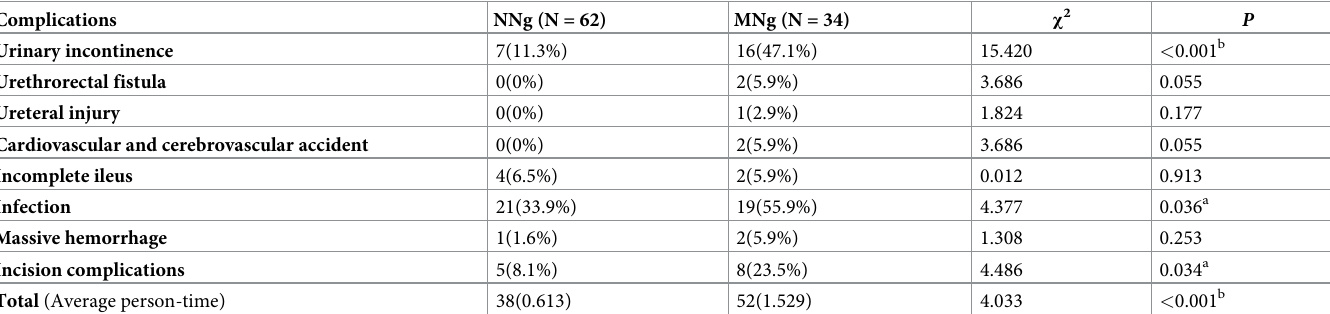
Table 2. Comparison of postoperative complications between the two groups.